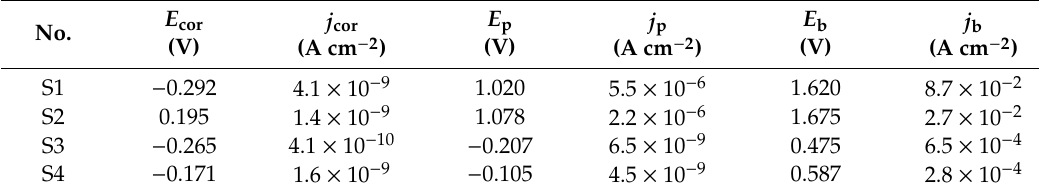
Table 3. Key electrochemical parameters for the NiTi alloy before and after surface modification after potentiodynamic measurements in Ringer’s solution at 37 ◦ C presented in Figure